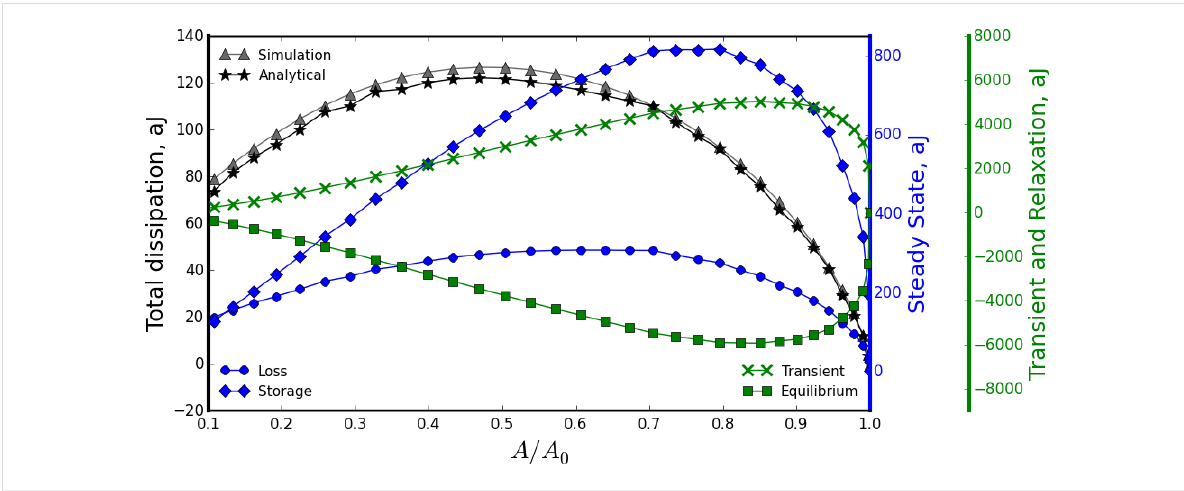
Figure 4: Typical dissipation spectroscopy curve, showing dissipated energy as a function of the ratio between tapping amplitude and free amplitude ( A / A 0 ). This plot shows how Equation 30 can decouple the total dissipated energy into meaningful viscoelastic components. The simulation results (see up-triangle symbols) correspond to the case of a flat-end-tip cantilever tapping over a polyisobutylene sample modeled through a Generalized Maxwell model (see Figure 1) with 26 arms (the parameters of the model were digitalized from the data provided by Brinson and Brinson [25], who fitted the experimental data of Catsiff and Tobolsky [6], and are provided in Table S1 in Supporting Information File 1). Star symbols show the analyti- cal calculation based on Equation 30, which closely follows the results obtained from the simulation. The analytical solution specifically gives the amount of dissipated energy that is proportional to the storage modulus (first term in Equation 30, diamond symbols), the amount of dissipated energy that is proportional to the loss modulus (second term in Equation 30, circle symbols), the amount of dissipated energy that is proportional to the tran- sients (third term in Equation 30, cross symbols), and the amount of dissipated energy that is related to the relaxation modulus (fourth term in Equa- tion 30, square symbols). The cantilever parameters of the AFM simulation are the same as the ones given in the caption of Figure